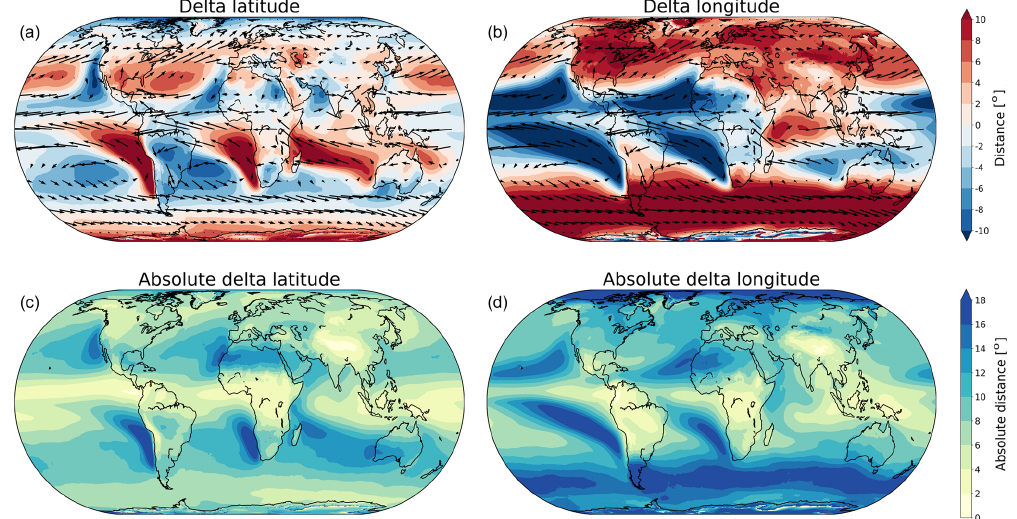
Figure 6. Average forward moisture transport from evaporation to precipitation. (a) Average of traveled distance in meridional direction (“delta latitude”). (b) Average of traveled distance in zonal direction (“delta longitude”). (c) Average of absolute traveled distance in merid- ional direction (“absolute delta latitude”). (d) Average of absolute traveled distance in zonal direction (“absolute delta